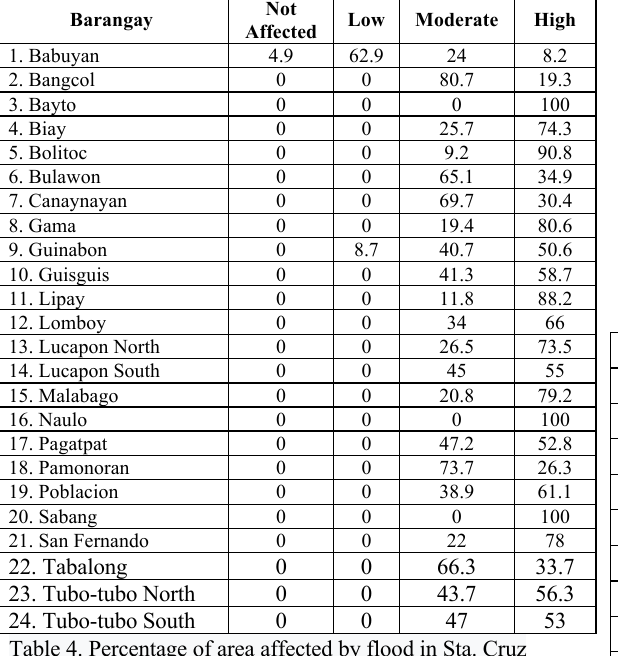
Table 4. Percentage of area affected by flood in Sta. Cruz